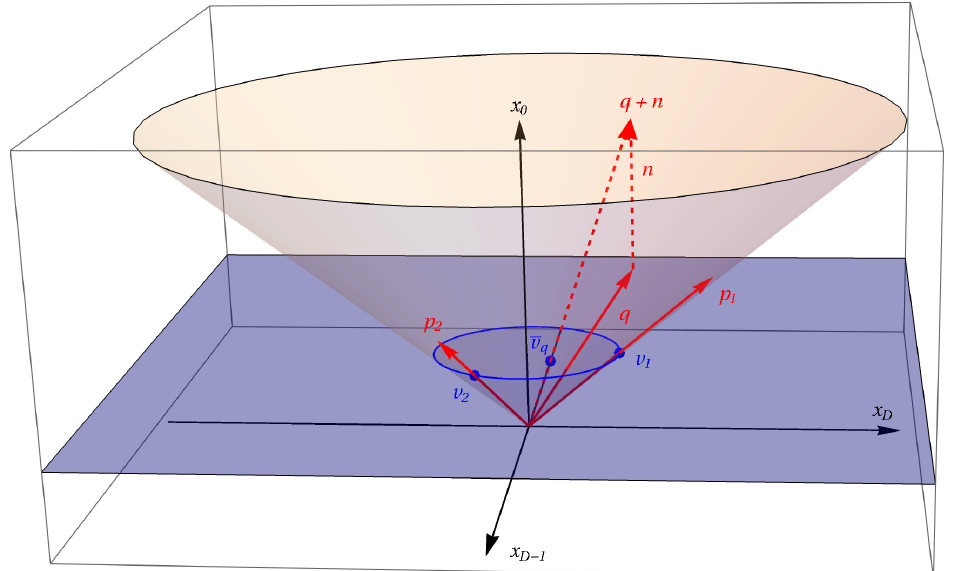
Figure 7 . The picture shows the 0 ≡ x 1 ≡ · · · ≡ x D − 2 slice of Minkowski space. The lightcone is shown in light yellow. The external momenta are depicted as red arrows, p 1 and p 2 are massless and hence on the light-cone, q has mass Q 2 and is inside the light-cone. The scaled momenta v , marked by blue dots, are in the blue x 0 ≡ 1 plane. The blue circle marks the intersection of the light-cone with the x 0 ≡ 1 plane. The dashed red momenta illustrate the construction of ¯ v q